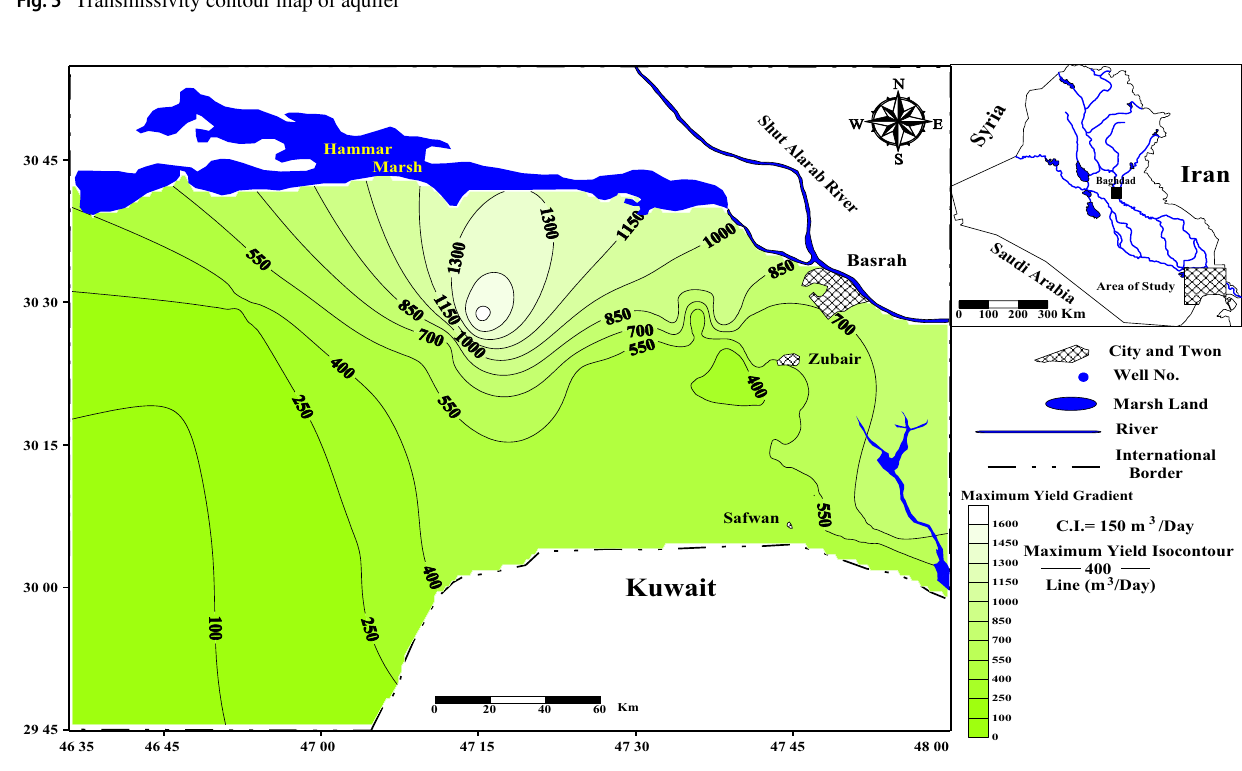
Fig. 5 Transmissivity contour map of aquifer